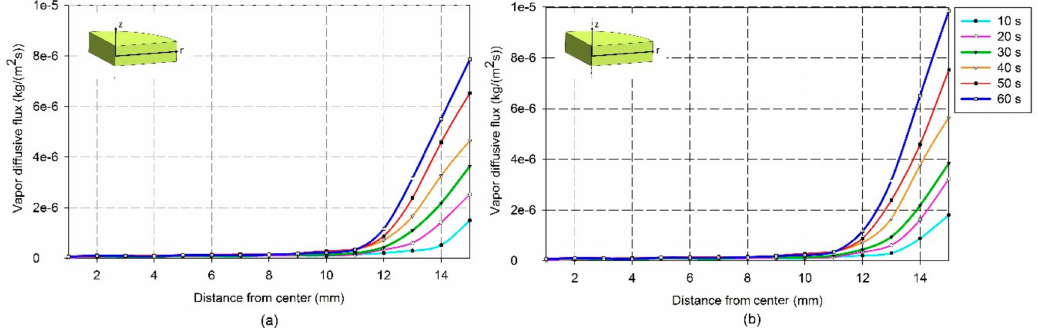
Figure 17. Vapor flux due to binary di ff usion of ( a ) unripe bananas and, ( b ) ripe bananas.